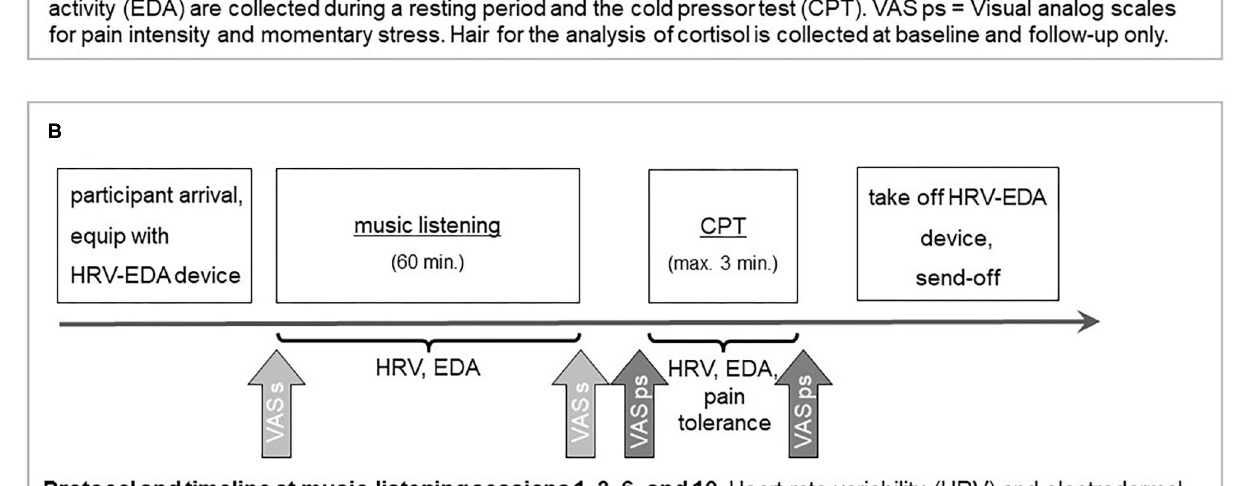
Beck Depression Inventory-II (101), Premenstrual